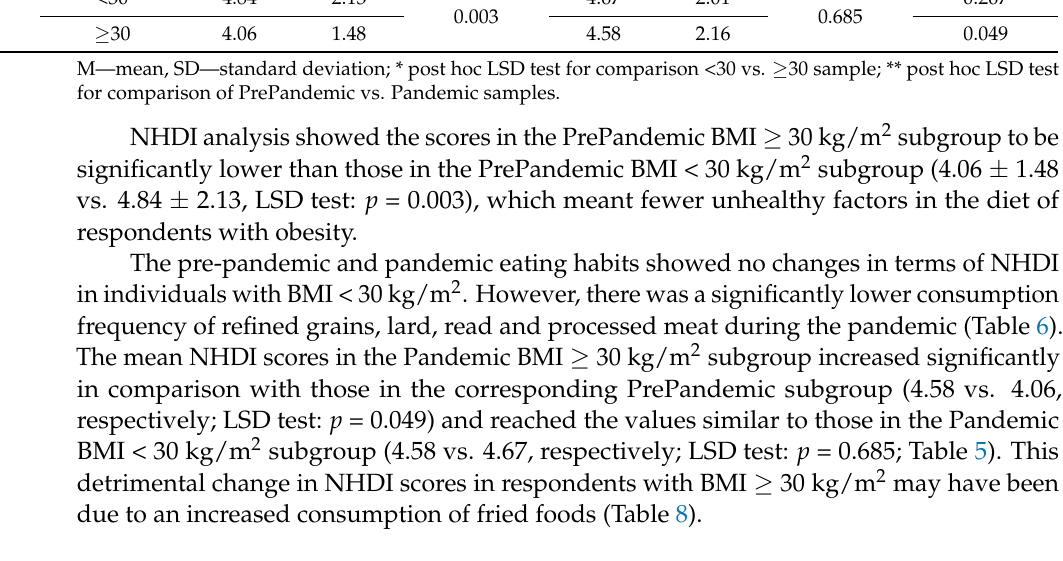
Table 8. Changes in the consumption frequency of selected foods from the Non-Healthy Nutrition Indicator during the pandemic.